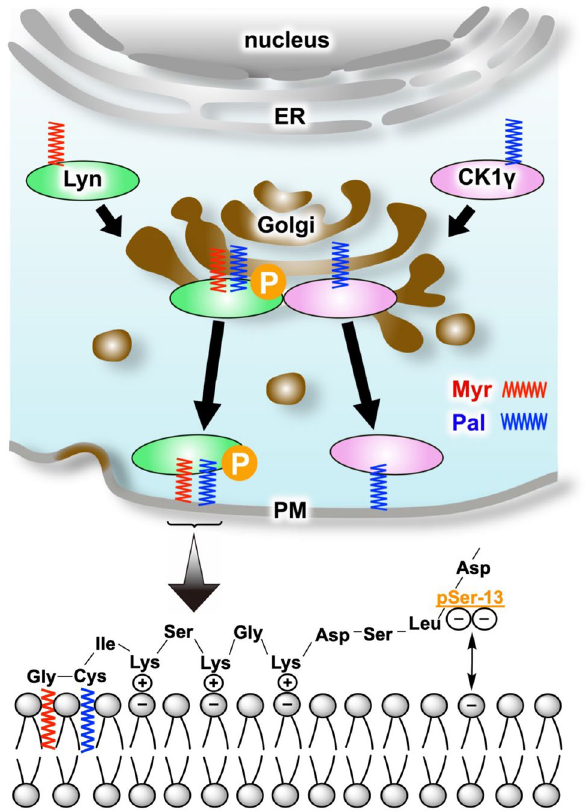
Figure 8. Schematic representation of targeting to the plasma membrane following N-myristoylation- dependent phosphorylation of Lyn. Scheme of binding to the plasma membrane following N-myristoylation- dependent phosphorylation of Lyn. Myr, myristate; Pal, palmitate; P, phosphate; ER, endoplasmic reticulum; PM, plasma membrane; −, negative charge; +, positive